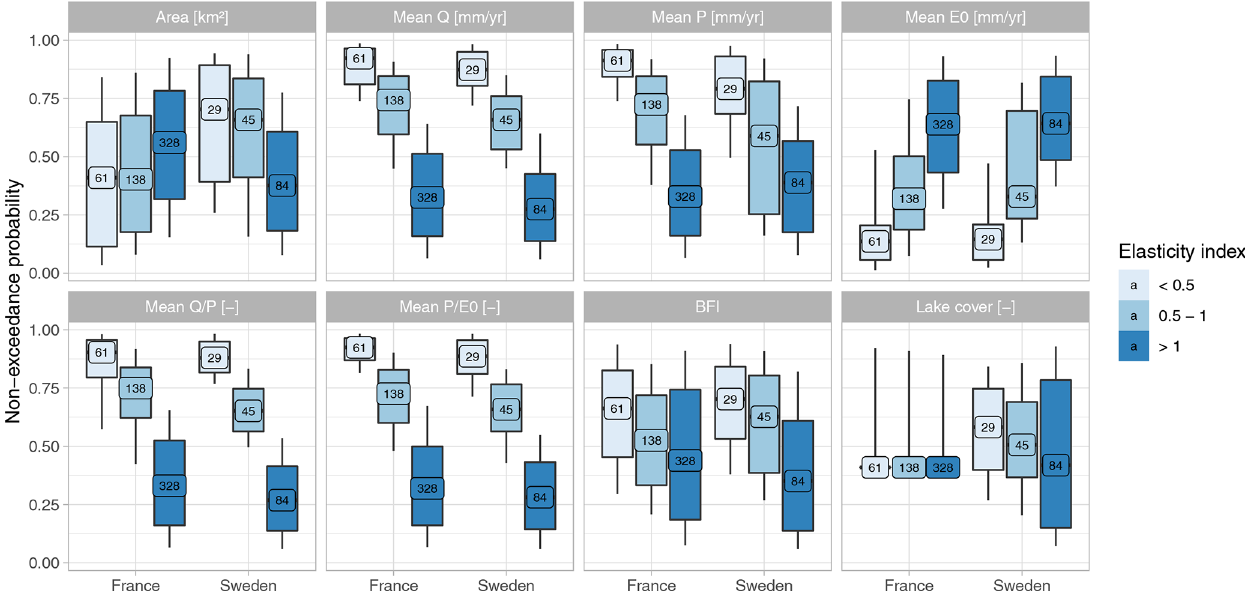
Figure 7. Distribution of hydroclimatic characteristics according to three classes of the elasticity index ( ε 2 ) in Eq. (2). The numbers within each boxplot describe the number of catchments. The boxes are delimited by quantiles 0.25 and 0.75; whiskers by quantiles 0.1 and 0.9.